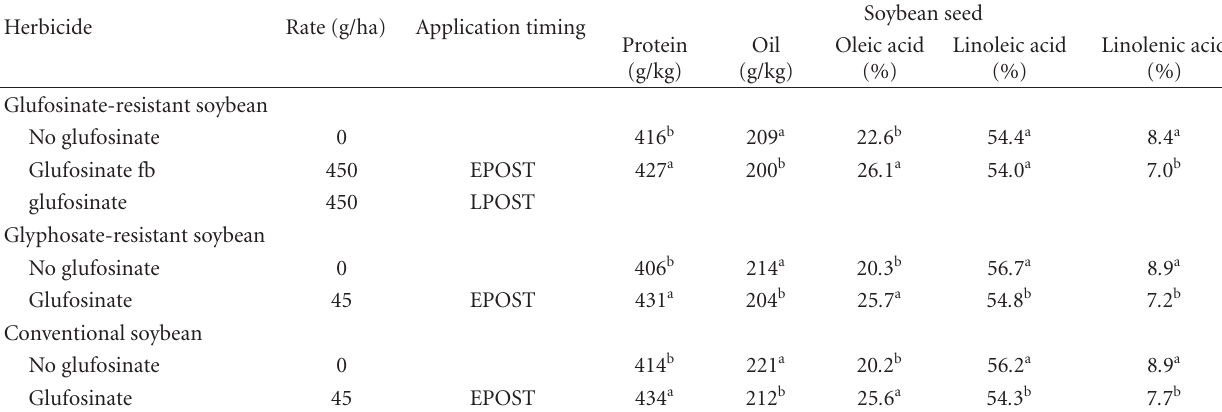
Table 6: E ff ect of glufosinate application on seed composition in glufosinate-resistant, glyphosate-resistant, and conventional soybean in a field study at Stoneville, MS, 2009 and 2010 a